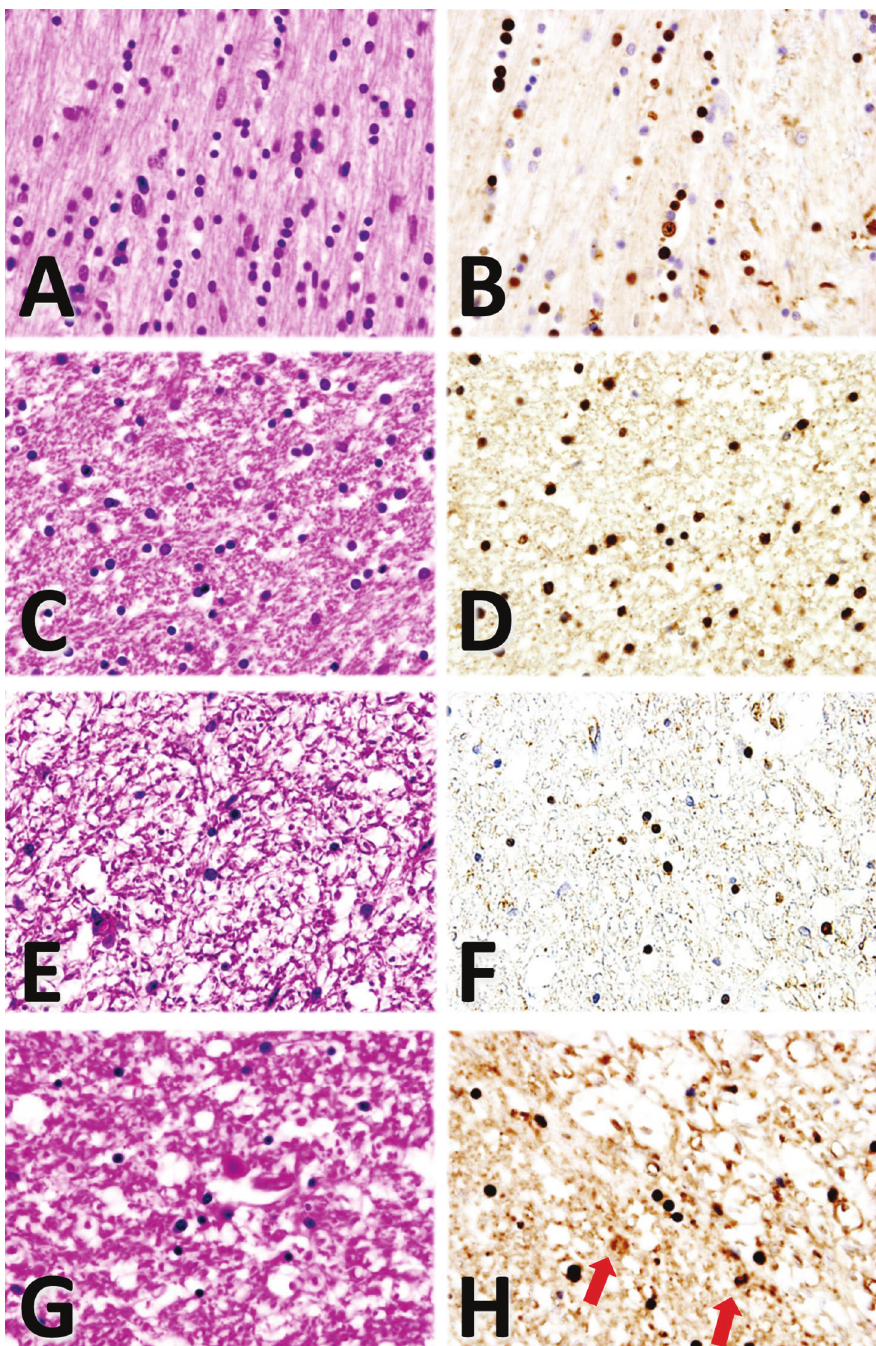
Figure 2: (A–H) Histological and immunohistochemical findings. Interfascicular oligodendroglia with halos in the cytoplasm and astrocytes are observed along with nerve fibers (A, HE staining). α -synuclein staining reveals numerous α -synuclein-positive glial cytoplasmic inclusions (GCI) in the oligodendroglia in the cerebral cortex (B). In the midbrain, the oligodendroglia and astrocytes show severe cytogenic edema (C, HE staining). α -synuclein-positive GCI in the oligodendroglia is also seen in the midbrain (D). The medulla oblongata shows extensive neuronal loss with scant oligodendroglial cells (E, HE staining), where α -synuclein is positive in the cytoplasma (F). Neuronal loss and gliosis are observed in the spinal cord (G, HE staining). Some α -synuclein-positive GCI in the oligodendroglia and astrocytes (arrows) are seen in the spinal cord